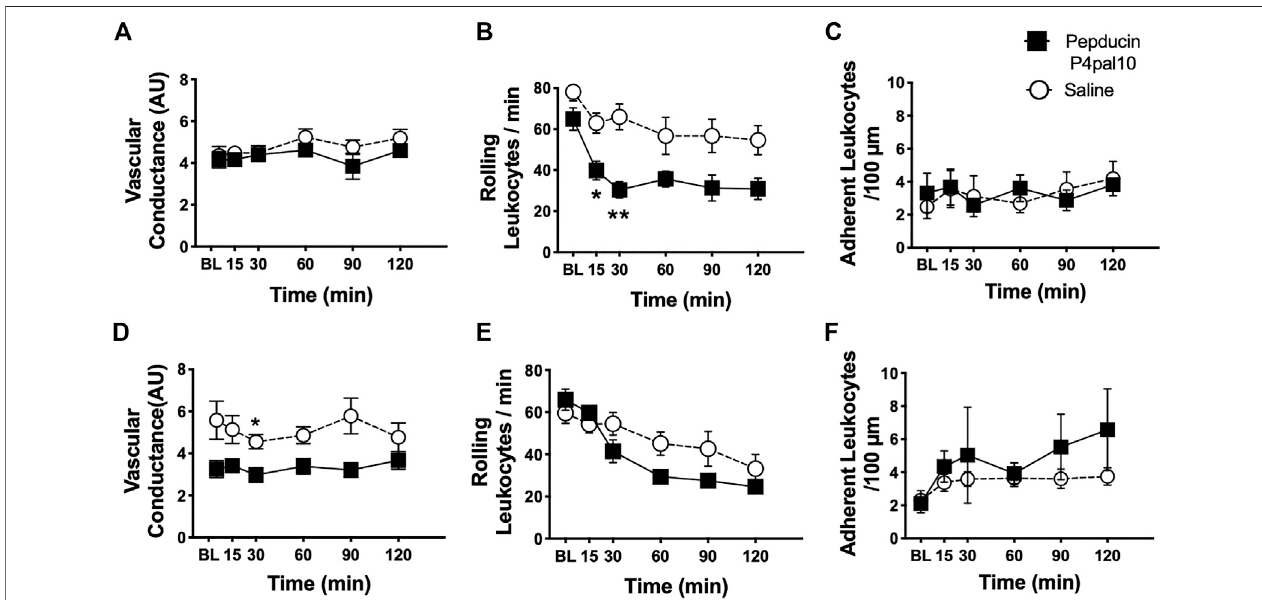
FIGURE7| EffectofPAR4BlockadeonJointIn fl ammation inEarlyOA/PTOA.Administrationofpepducin P4pal10failedtoimprovevascularconductance (A) ( p > 0.05, 2-way RM-ANOVA, n (cid:1) 6) but signi fi cantly reduced rolling leukocytes in day 3 MIA animals (B) ( p < 0.05, 2-way RM-ANOVA, n (cid:1) 6). No signi fi cant effect was observed on adherent leukocyte traf fi cking in the same animals (C) ( p > 0.05, 2-way RM-ANOVA, n (cid:1) 6). PAR4 blockade in day 7 MMT animals did induce signi fi cant reductions in both vascular conductance (D) and rolling leukocytes (E) ( p < 0.05, 2-way RM-ANOVA, n (cid:1) 9 – 12) but failed to inhibit adherent leukocyte movement (F) ( p > 0.05, 2-way RM-ANOVA, n (cid:1) 9 – 12). * p < 0.05, ** p < 0.01 denotes statistical signi fi cance using post hoc Sidak ’ s Multiple Comparisons Test. Data presented as means ± SEM.